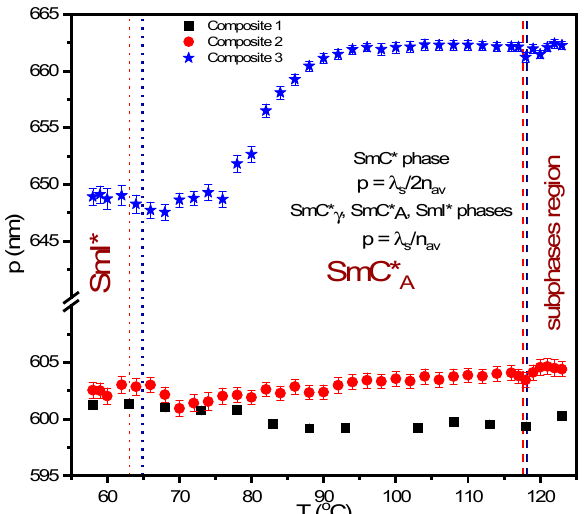
Figure 6. Temperature dependence of the helix pitch for Composites 1–3 obtained during cooling together with the relations between the helix pitch and the wavelength in the maximum transmission for the antiferroelectric and ferroelectric phases. The dashed and dotted vertical lines indicate the SmC* γ –SmC* A and SmC* A –SmI* phase transition temperatures obtained by DSC.